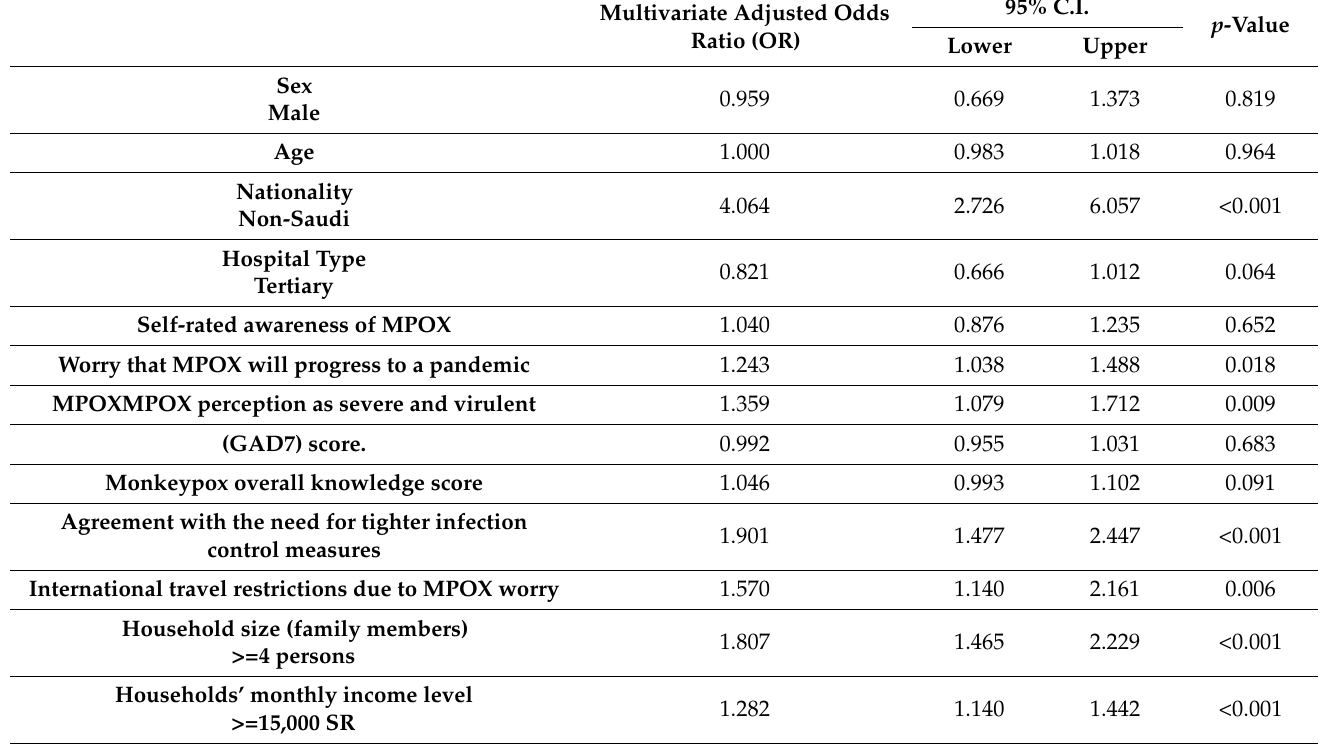
Table 3. Multivariate binary logistic regression analysis of the HCW’s MPOX information-seeking behavior. (KSA, 27 May to 5 June